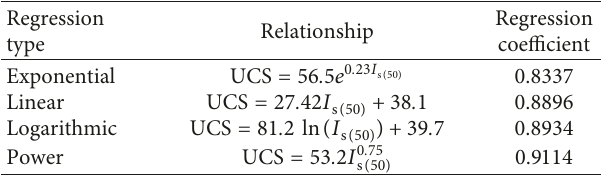
Figure 7: RMT ∼ 201 rock test machine.